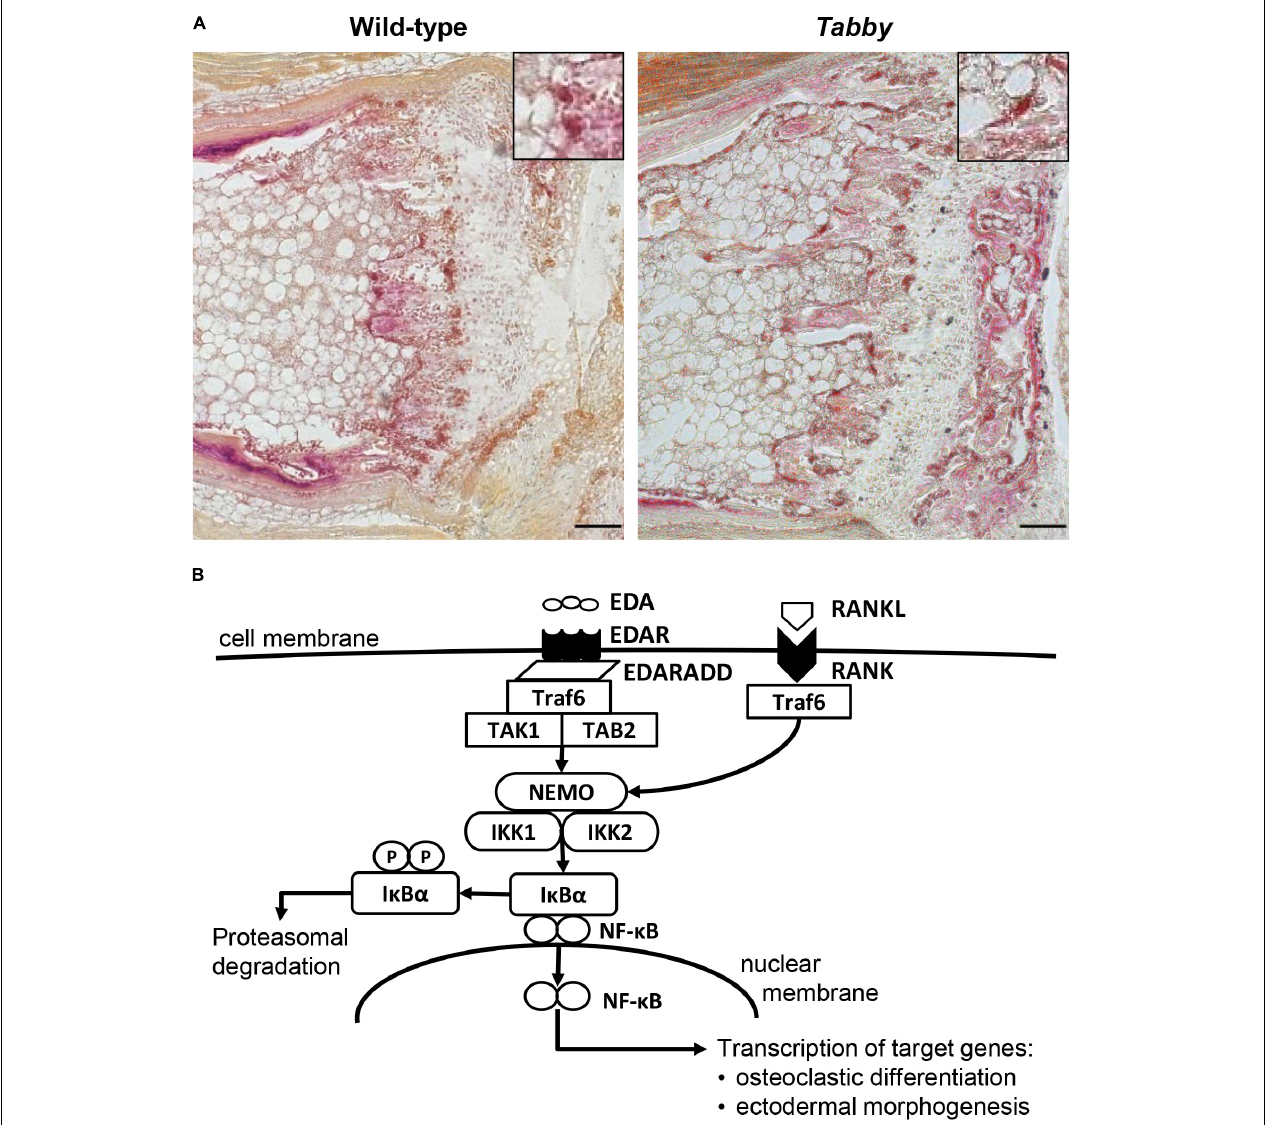
FIGURE 3 | Possible role of EDA1 in the differentiation of osteoclasts. (A) Representative tartrate-resistant acid phosphatase (TRAP)-stained tail sections of wild-type and Tabby mice indicating similar number and distribution of osteoclasts in the metaphyseal trabecular part of vertebral bones. The boxes in the upper right corner show magnified osteoclasts (dark red). (B) Overview of the molecular link between the EDA1 pathway and the RANK–TRAF6–NF κ B pathway and its possible involvement in osteoclastic differentiation. Scale bar: 100 µ